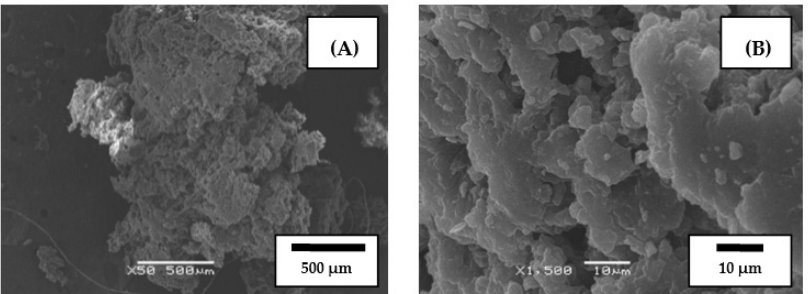
Figure 2. SEM images of butadiene styrene thermoplastic elastomer particle (SBS L 30 ‐ 01) ( A ) and its segment ( B ).